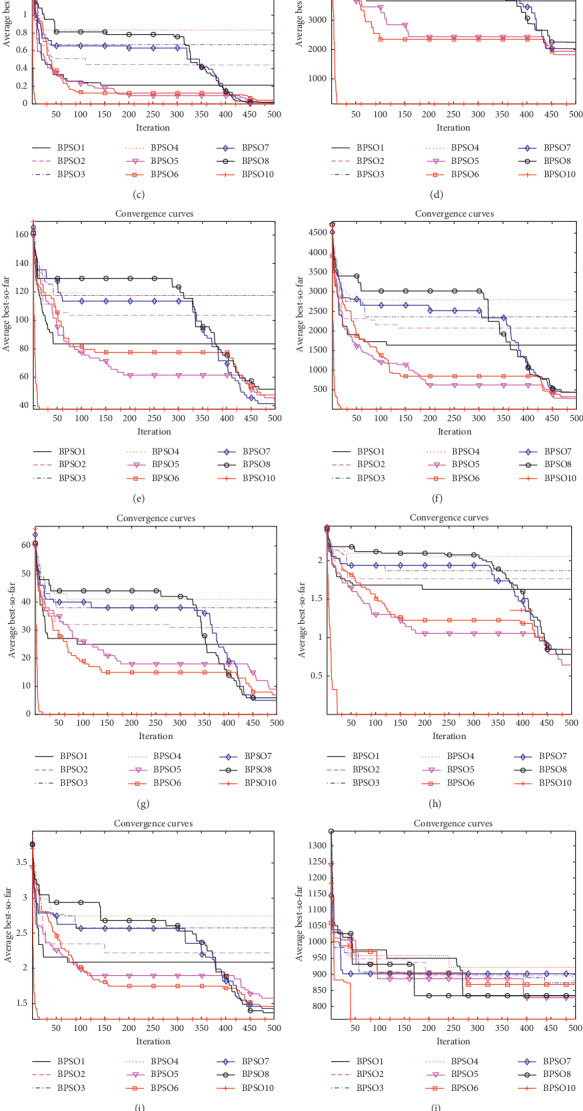
Convergence curves of the benchmark functions. (a) F1. (b) F2. (c) F3. (d) F4. (e) F5. (f) F6. (g) F7. (h) F8. (i) F9. (j) F10. (k) F11. (l) F12.